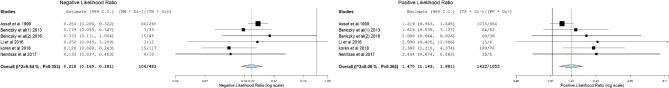
Forest plot showing negative and positive likelihood ratios of the IC-ESI studies (individual studies: size of the squares are proportional to weights used in meta-analysis; the summary measure: center line of the diamond; associated 95% confidence intervals: lateral tips of the squares and the diamond).